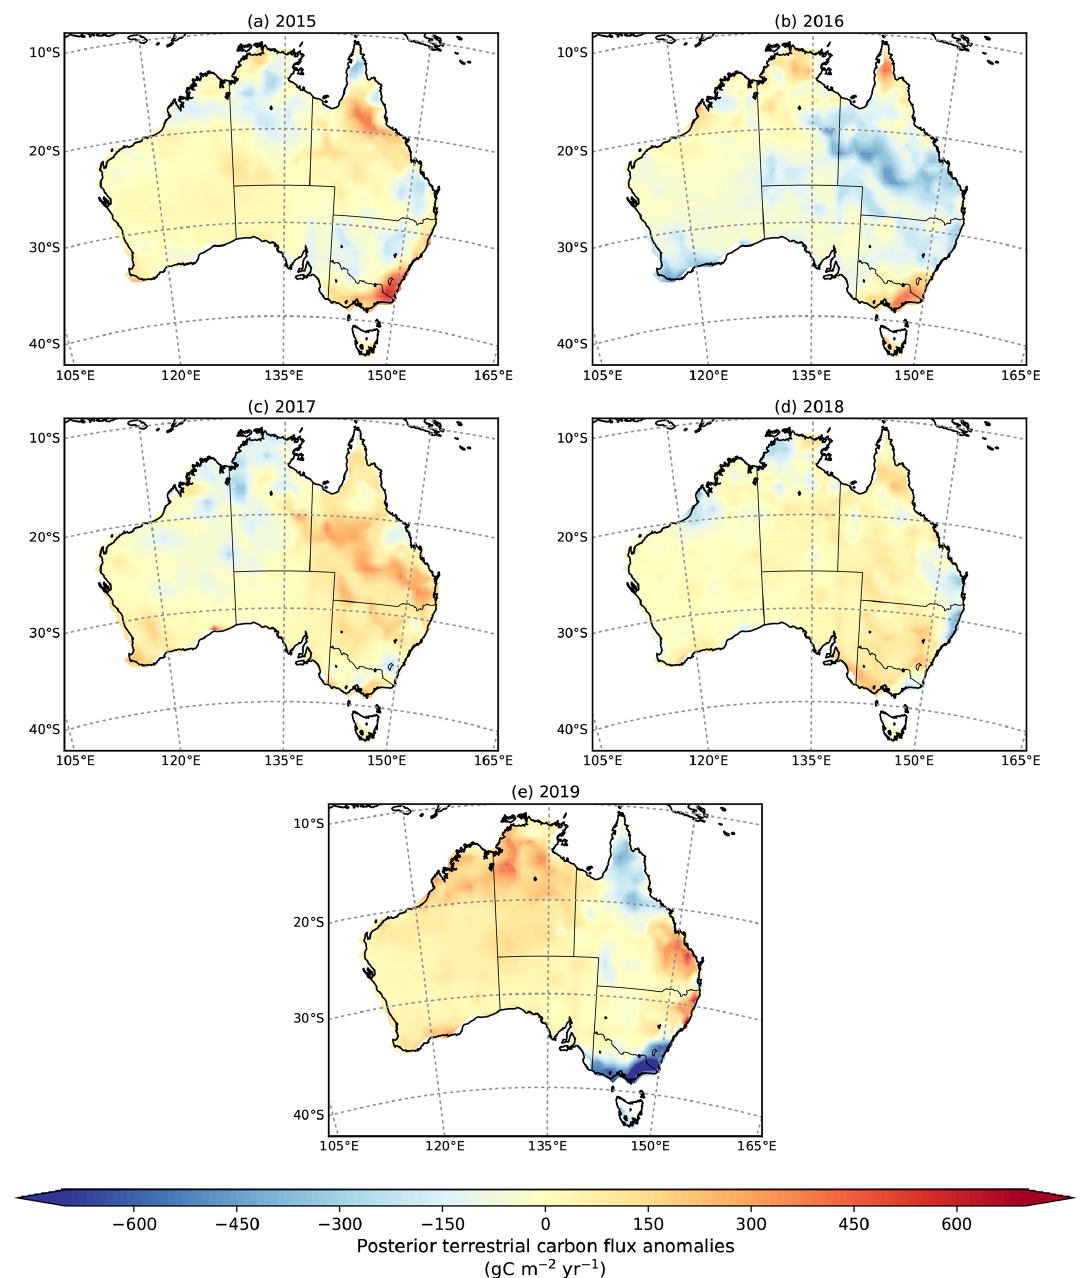
Figure 10. Spatial distribution maps of the annual posterior terrestrial carbon flux anomalies (gCm − 2 yr − 1 ) for 2015–2019 (a, b, c, d, e) . Negative anomalies correspond to a larger-than-average uptake of carbon by land ecosystem, whereas positive anomalies correspond to a larger-than-average release of carbon to the atmosphere from the